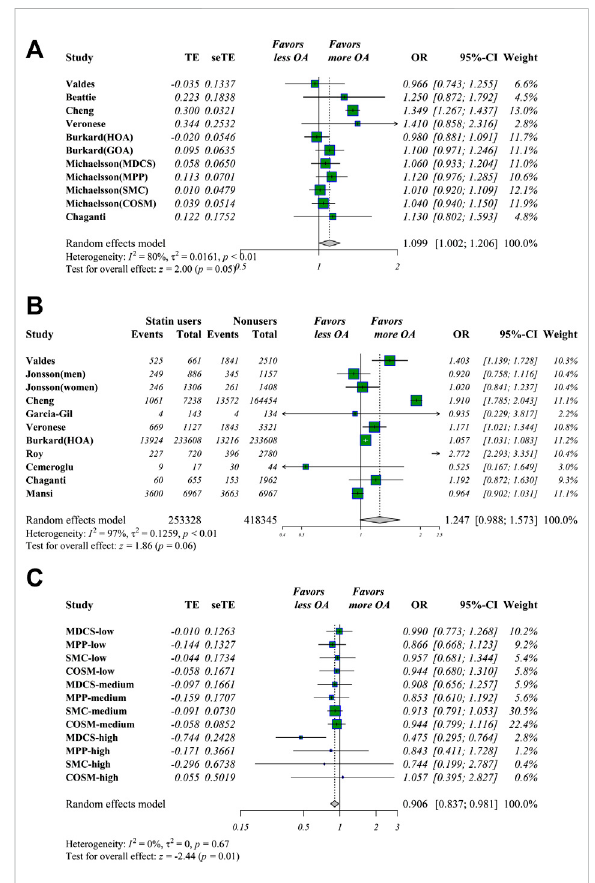
FIGURE 2 Meta-analysis of estimations of statin use and OA risk. Meta- analysis of overall adjusted estimations (A) and raw data (B) of statin users vs. nonusers for OA risk. Statin use was linked to signi fi cantly higherOAriskinadjustedestimationsinadjusted OR values and raw data (C) Meta-analysis of potential impacts of antihypertensive drugs (AHDs) on hypertensive statin users. AHD use may be linked to decreased OA risk in hypertensive statin